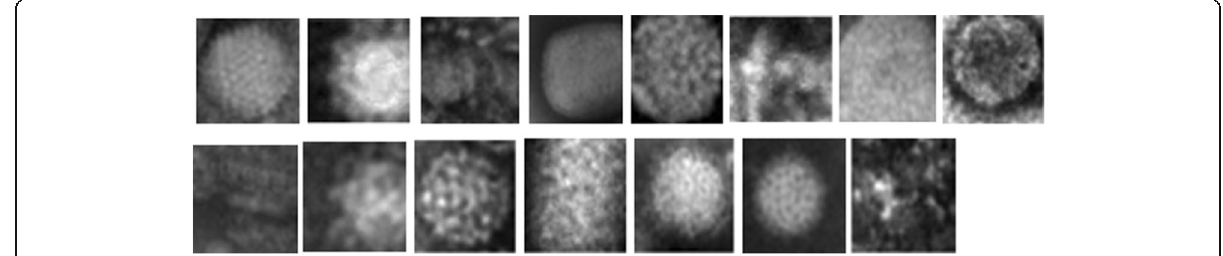
Fig. 17 Sample images from Virus database. Fifteen classes of virus images from Virus database are